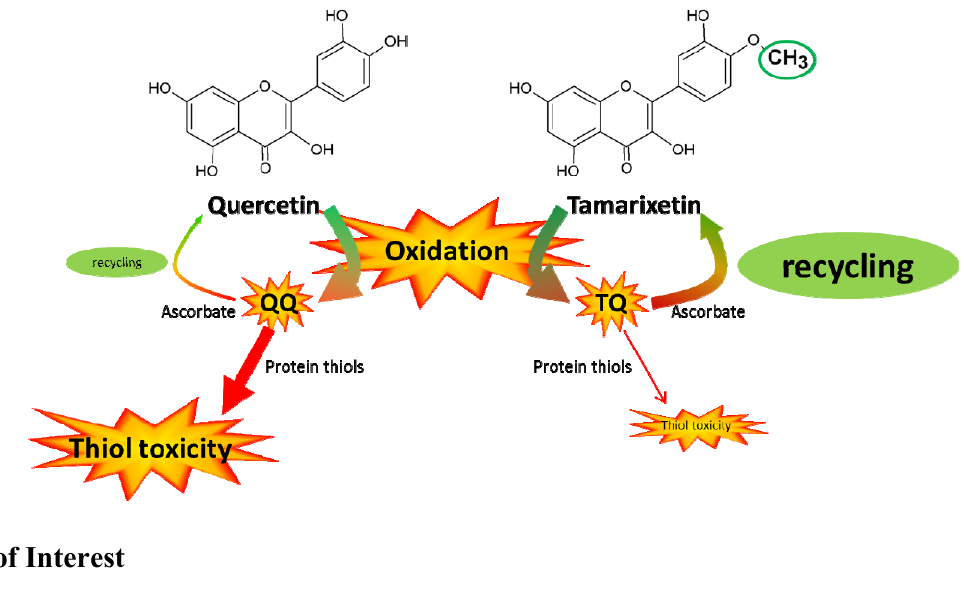
Figure 5. Overview of the difference in thiol toxicity between quercetin and tamarixetin. Tamarixetin and quercetin both protect against radical toxicity. The oxidized products that arise in this process (QQ and TQ) are thiol reactive. In the presence of ascorbate TQ preferentially passes its reactivity to ascorbate. An extra advantage is that ascorbate recycles TQ to the parent